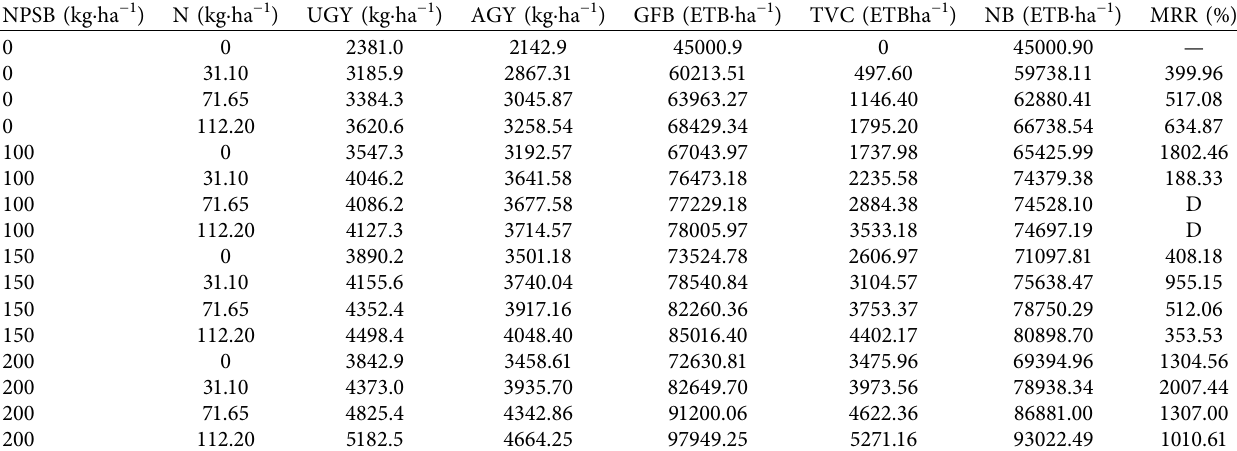
Table 8: Economic analysis of the effects of NPSB and nitrogen application on bread wheat. NPSB (kg · ha − 1